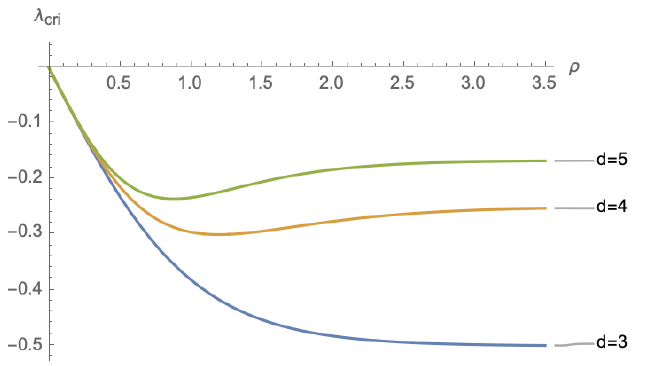
Figure 4 . The lower bound λ cri ( ρ ) in various dimensions. The larger the spacetime dimension is, the larger the lower bound